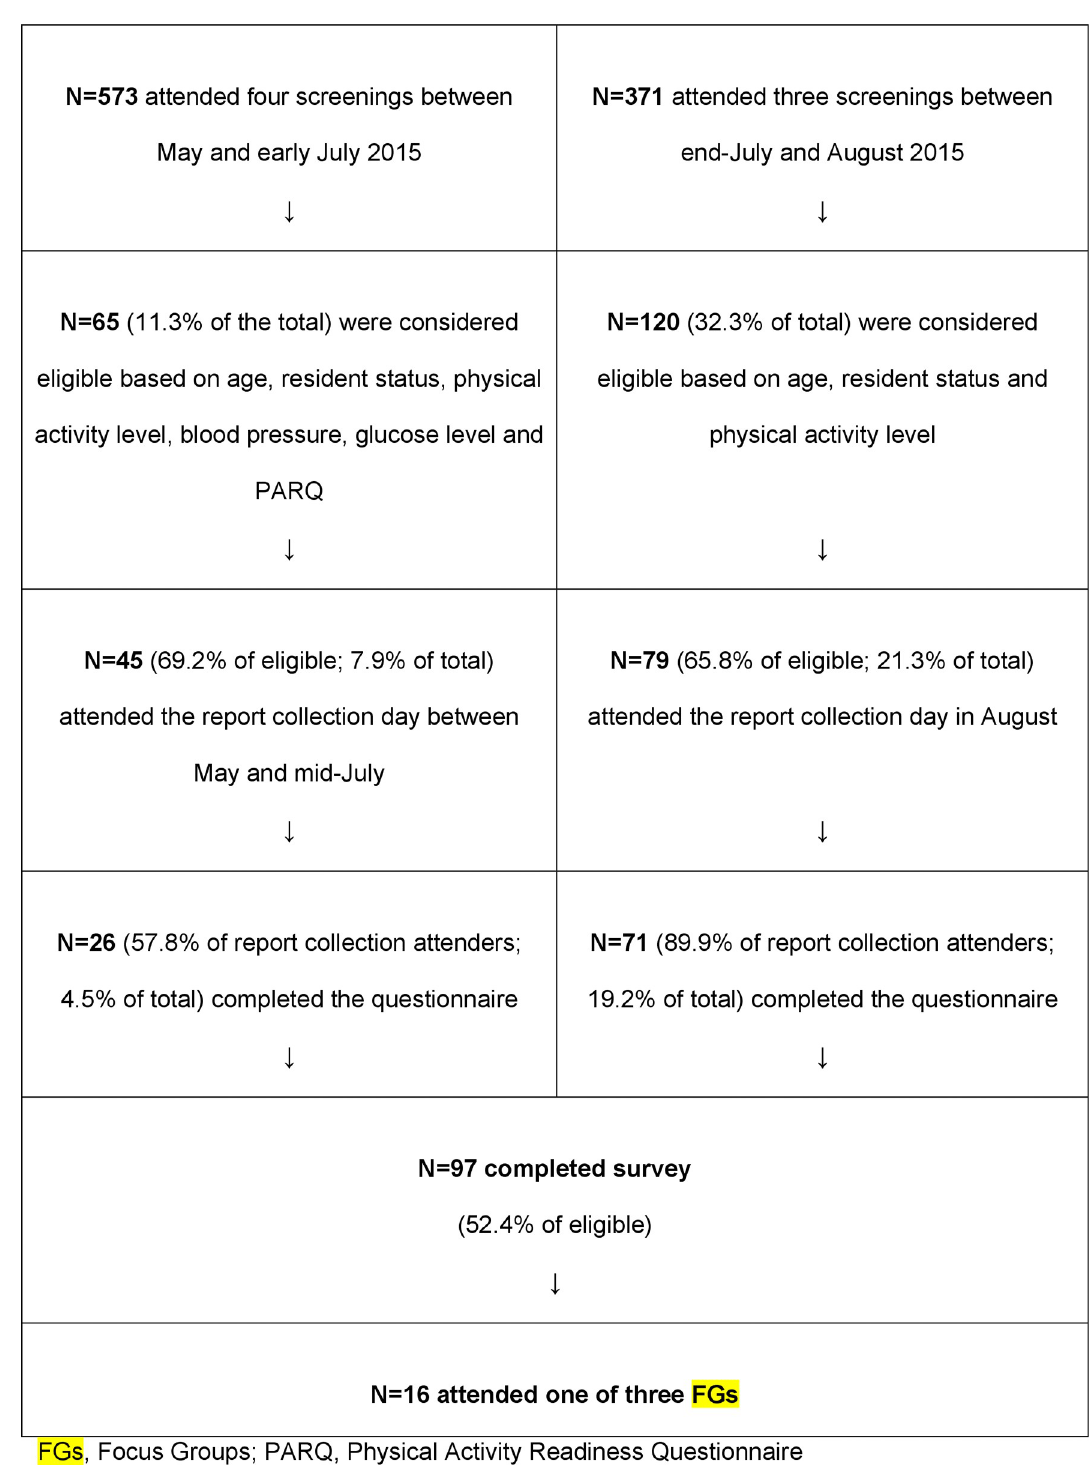
Fig 1. Flow chart of participant recruitment in the Park Prescription Study.